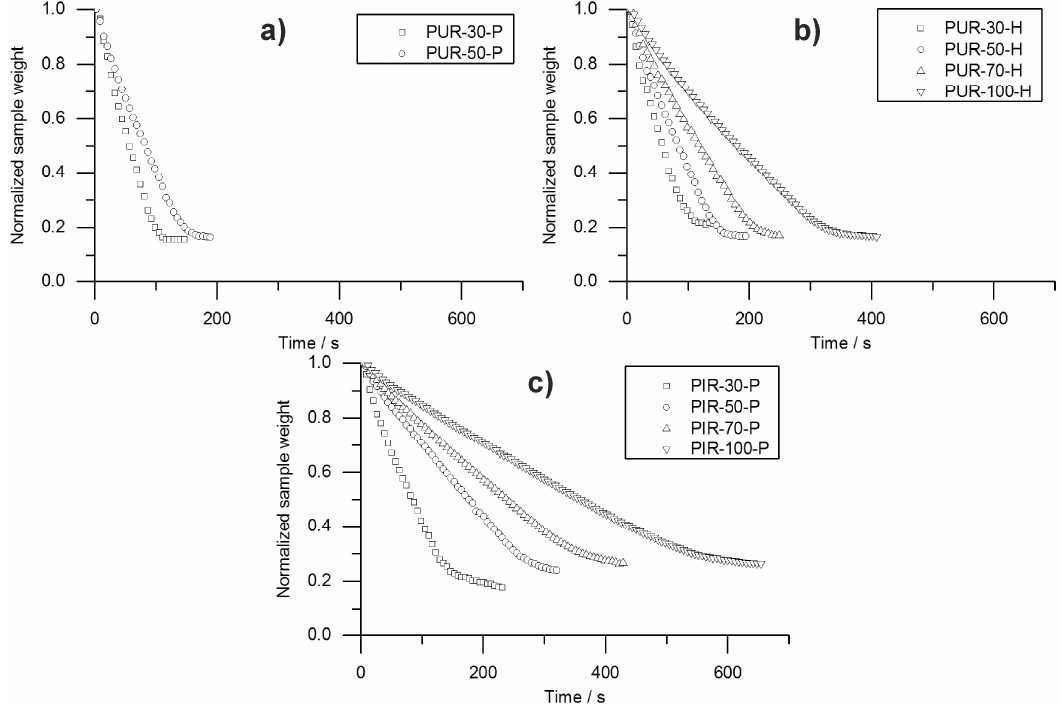
Figure 9. History of normalized sample weight for ( a ) PUR-P, ( b ) PUR-H and ( c ) PIR-P foams.